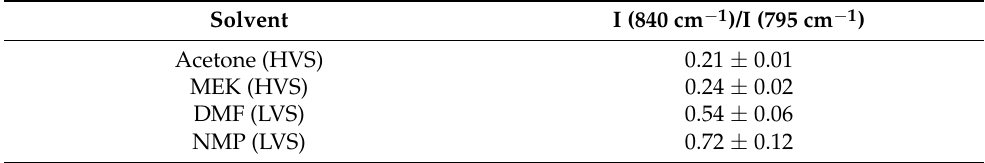
Figure 3. Raman spectra of the virgin P(VdF-HFP) films processed from different solvents ( left ). Detailed view of the representative region of the Raman spectra ( top right ) with band assignments for main phases of P(VdF) [2,8,10]. All Raman spectra are normalized to the highest band at 795 cm − 1 , characteristic of the α -phase. XRD of the different copolymer films processed from different solvents ( bottom right ). Marked positions for reflexes are expected for the three main phases of P(VdF) [2]. The graphs are normalized to the main reflex at 8.3 ◦ for better comparison. Table 4. Ratios for Raman band intensities at 840 cm − 1 and 795 cm − 1 , characteristic for polar and nonpolar crystalline structure in P(VdF),